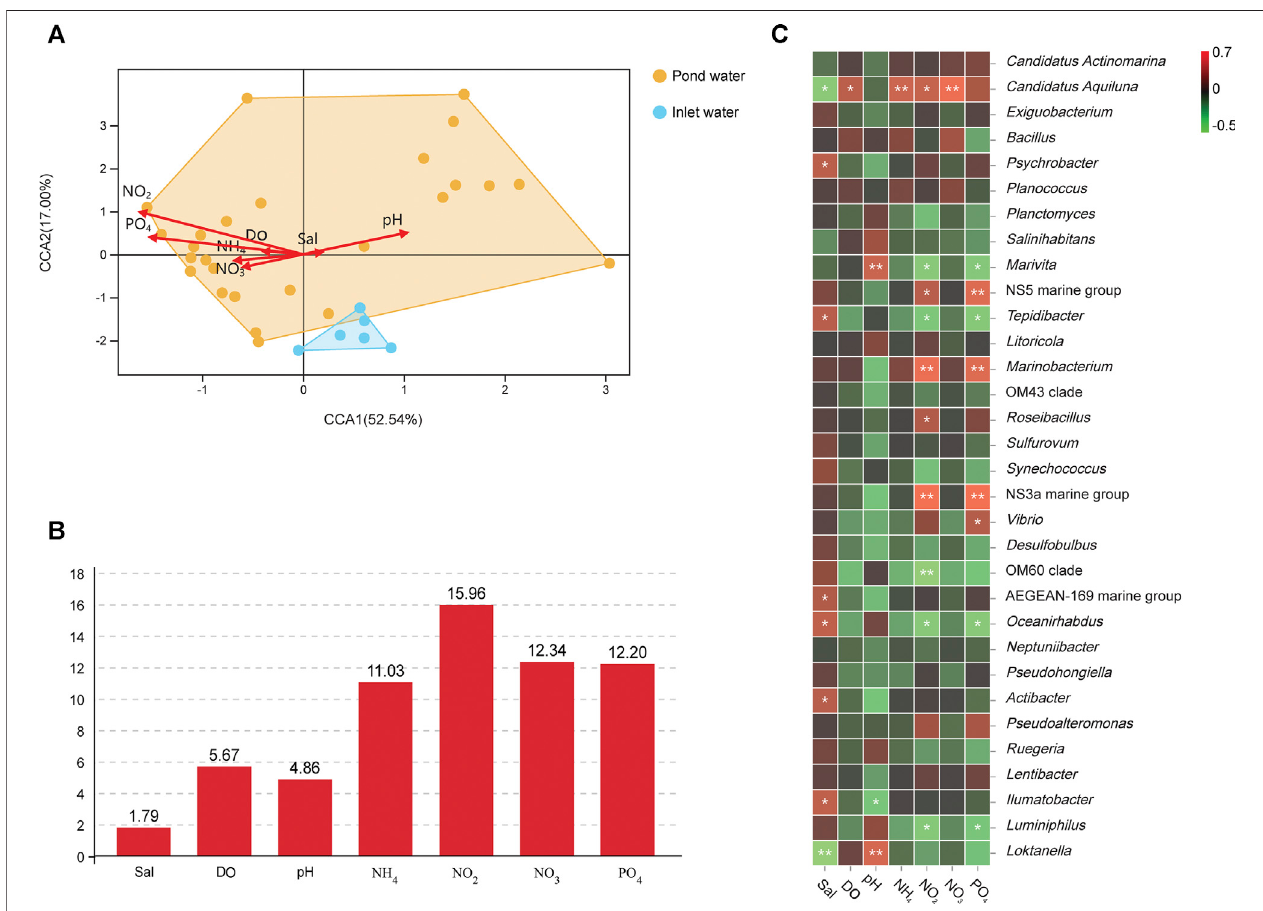
FIGURE 5 | CCA analysis of physicochemical factors and bacterial communities (A) ; environmental contribution analysis (B) ; correlation analysis between dominant bacterial taxa and physicochemical factors (C) .